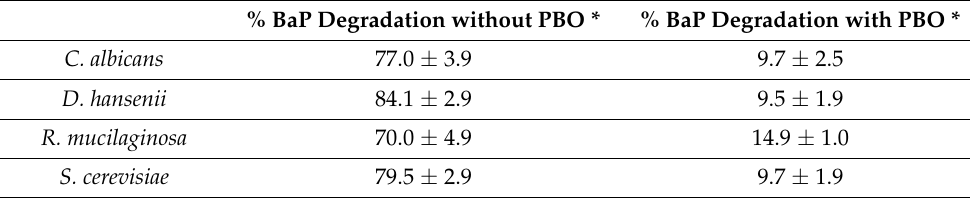
Table 2. The degradation of benzo(a)pyrene (BaP) and its inhibition induced by piperonyl butoxide (PBO). % BaP Degradation without PBO * % BaP Degradation with PBO *